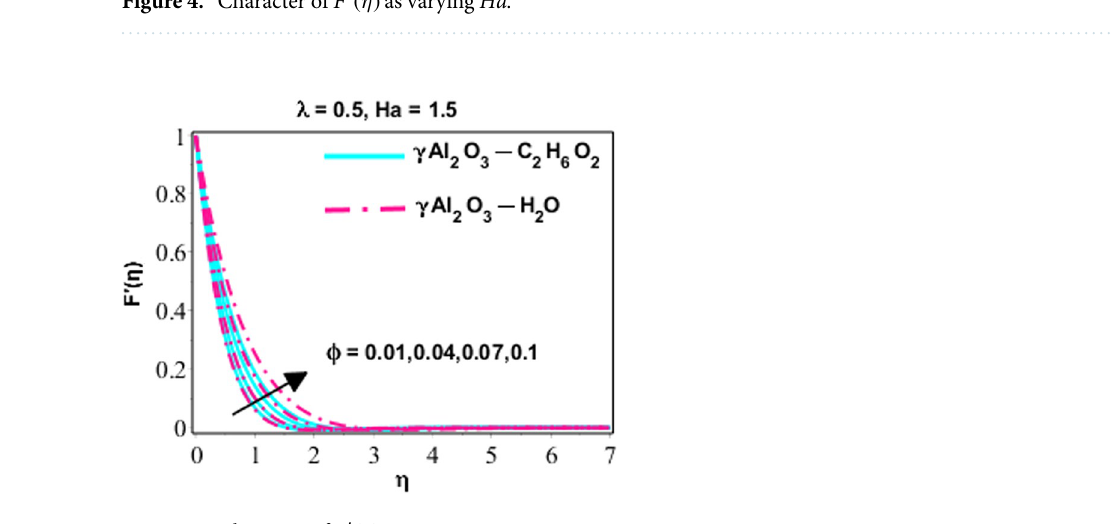
Figure 5. Character of F ′ (η) as varying φ